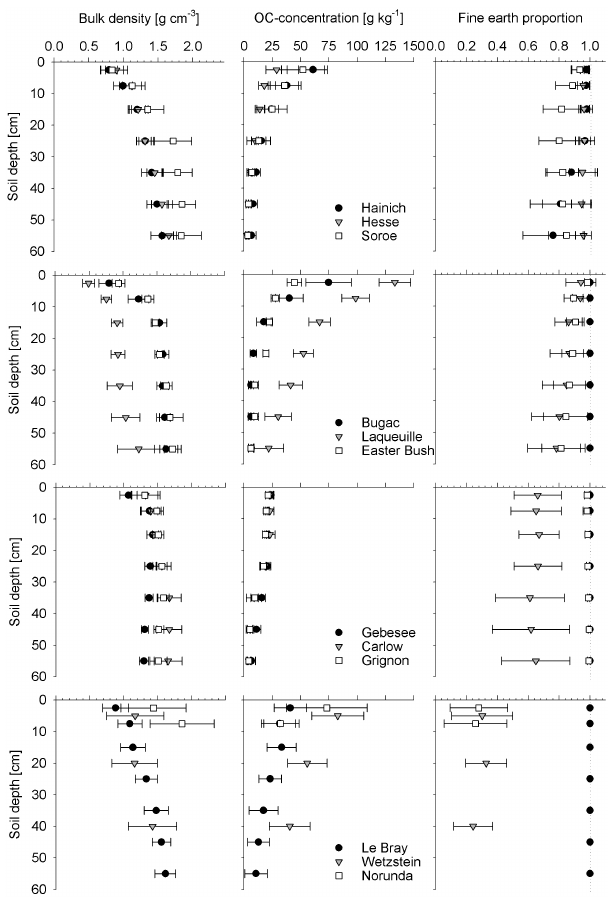
Fig. 2. Depth distribution of average soil bulk densities (BD), OC concentrations, and the fine earth contents ( ± one standard devia- tion) at the study sites.